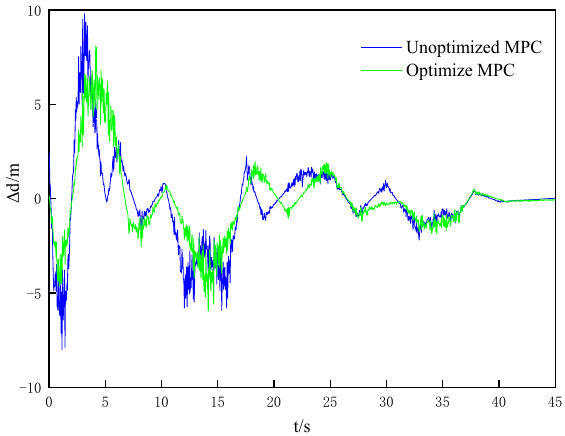
Figure 8. The test results of vehicle spacing.